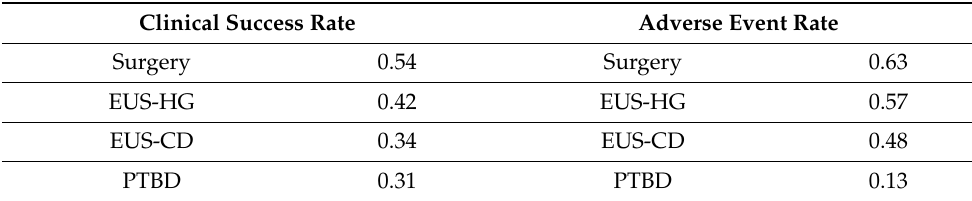
Table 3. SUCRA score ranking of the tested interventions.